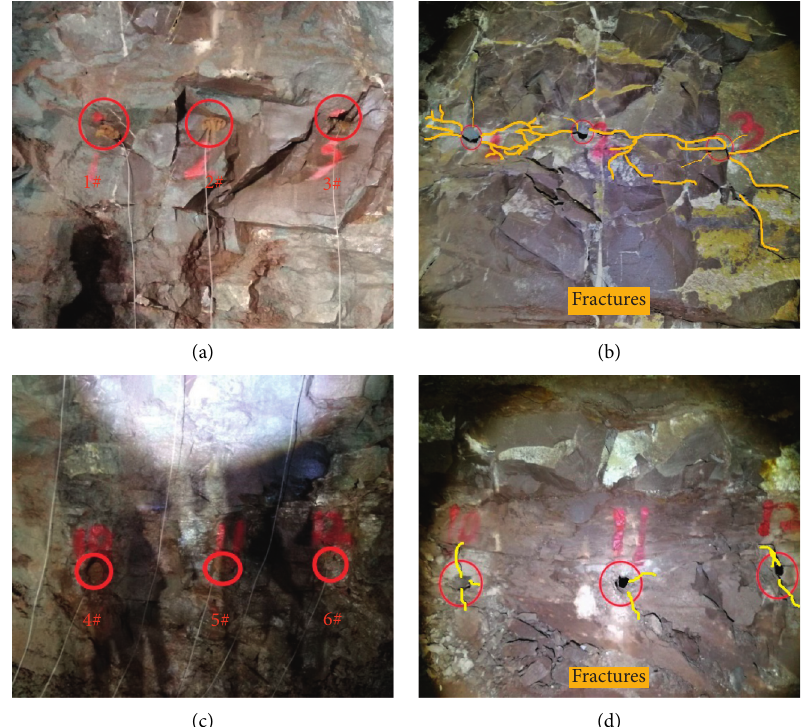
Figure 5: Effect before and after experimental blasting. (a) Effect of group A before blasting. (b) Effect of group A after blasting. (c) Effect of group B before blasting. (d) Effect of group B after blasting.